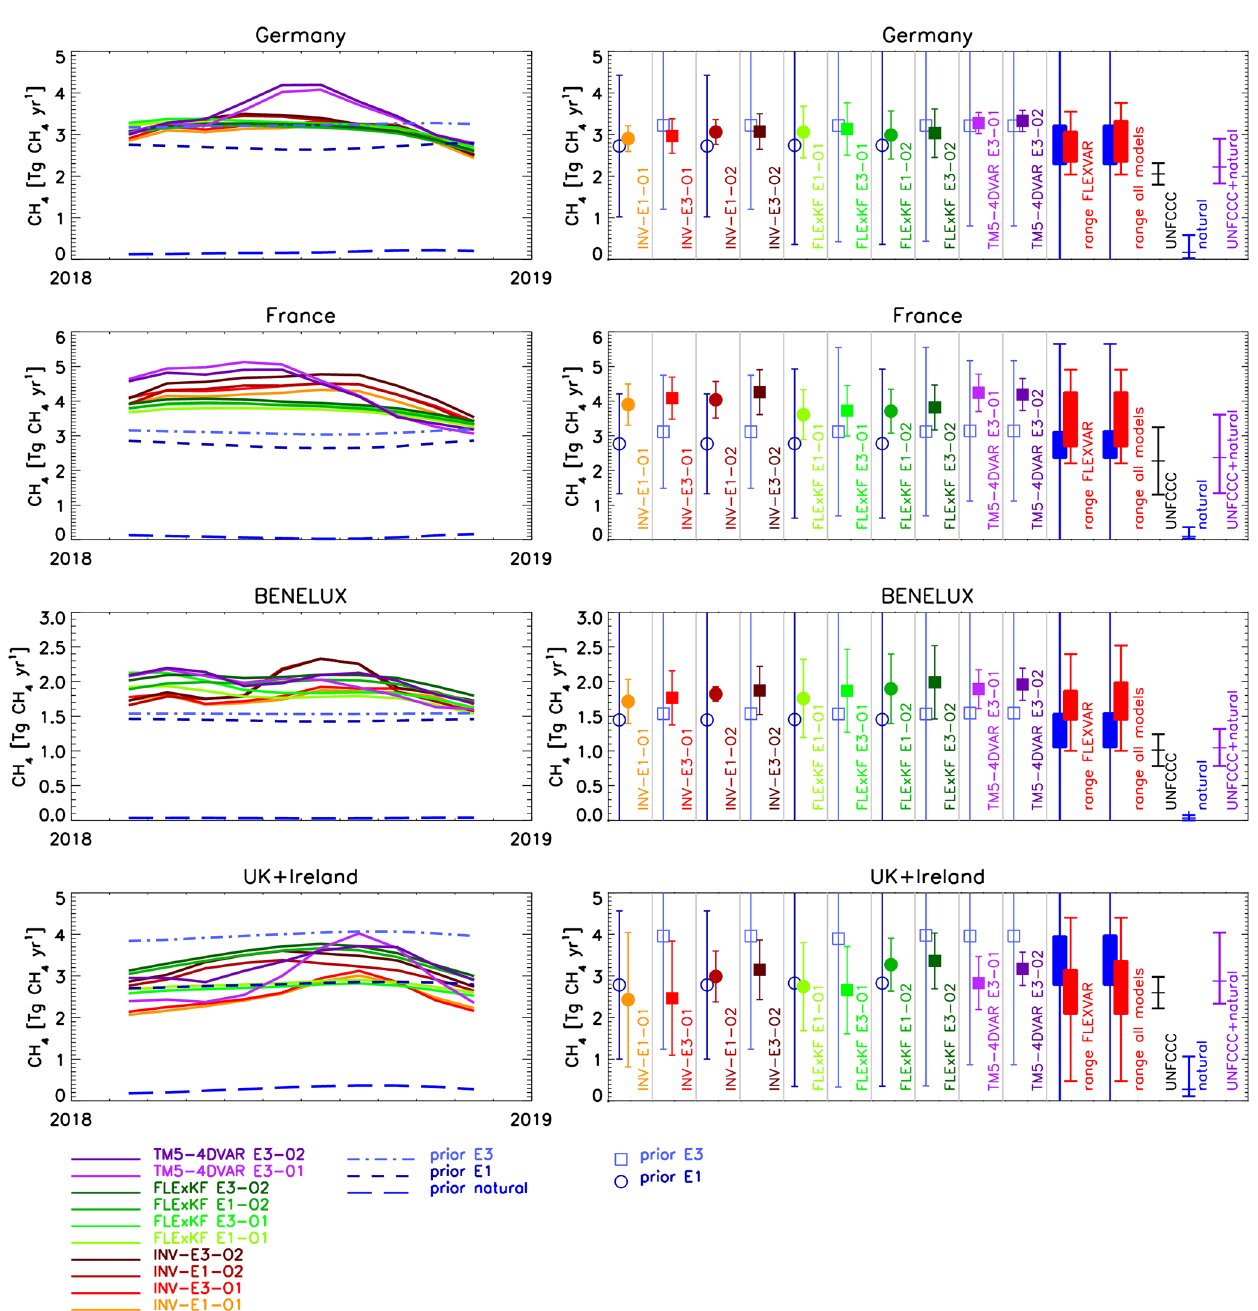
Figure 7. Total CH 4 emissions for Germany, France, BENELUX, and UK + Ireland derived by the three different inverse modelling systems FLEXVAR, FLExKF, and TM5-4DVAR. For FLEXVAR only a subset of inversions is displayed here, while the whole range from all FLEXVAR sensitivity inversions is shown by the first pair (from left to right) of solid rectangles, which is identical to the pair of rectangles shown in Fig. 2. The second pair of rectangles shows the range of prior (blue) and posterior (red) CH 4 emissions from all three models (and the error bars the minimum and maximum values of the 2 σ uncertainties of all individual inversions). The black symbols show the anthropogenic CH 4 emissions reported to UNFCCC (and their estimated 2 σ uncertainties), blue symbols the natural emissions estimated from the GCP CH 4 inventory, and the violet symbols the sum of anthropogenic and natural bottom-up inventories.